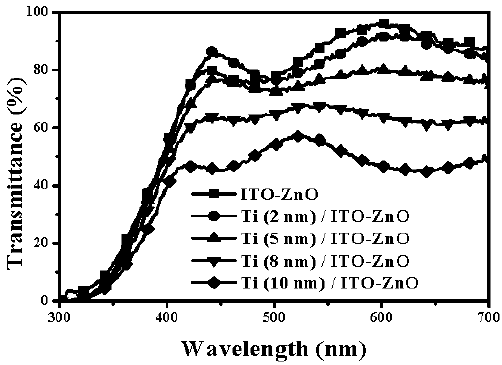
Figure 5. ( a ) I-V characteristics of the ITO-ZnO/Ti/ n -GaN contact system as a function of the Ti interlayered thickness, measured from the contact spacing of 15 µ m (the I-V curve of the Al/Ti/ n -GaN contact system also is shown for comparison) and ( b ) the corresponding specific contact resistance as a function of the Ti layered thickness.